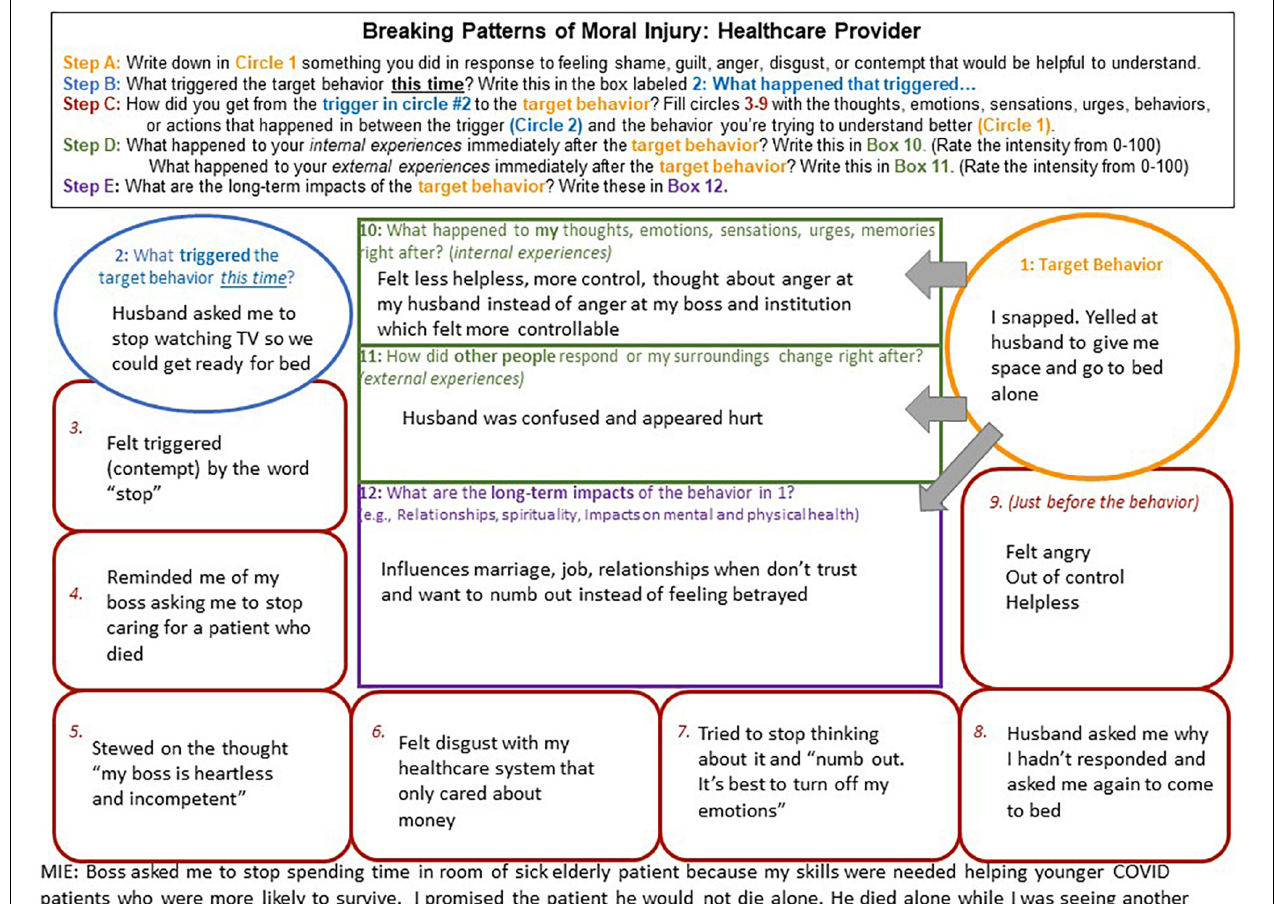
FIGURE 3 | A healthcare provider example of a chain analysis demonstrating the factors maintaining moral